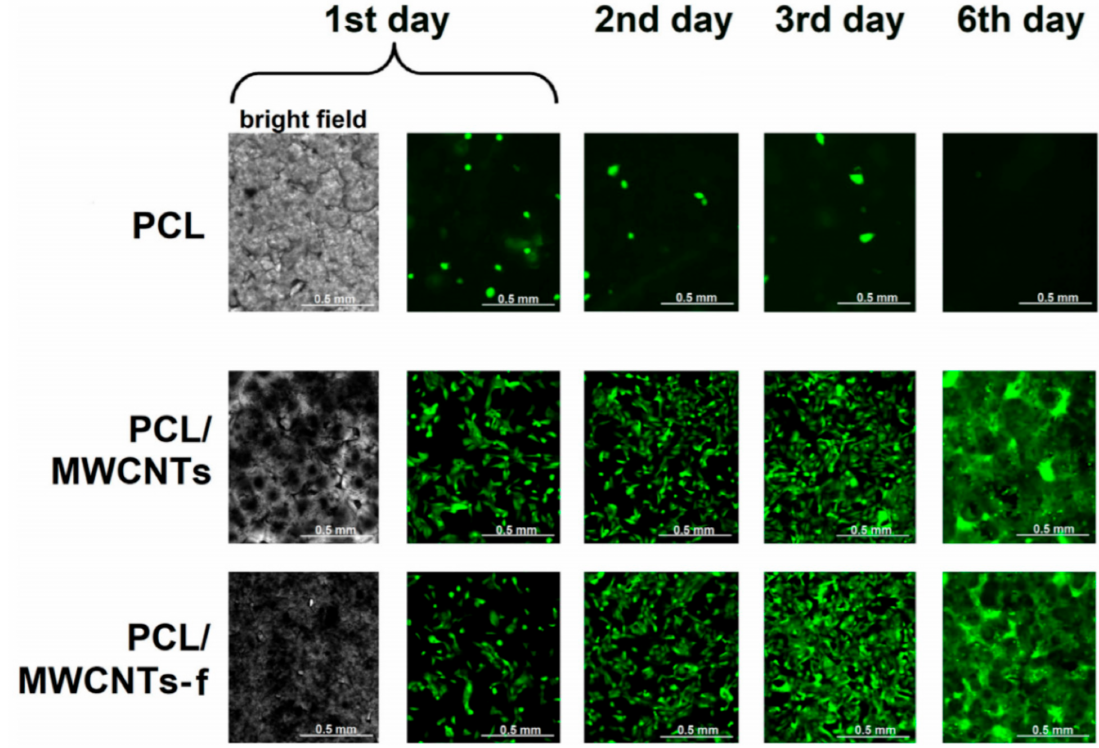
Figure 2. Human osteoblast-like fluorescence microphotographs U-2 OS-Green cells’ growth on tested nanomaterials